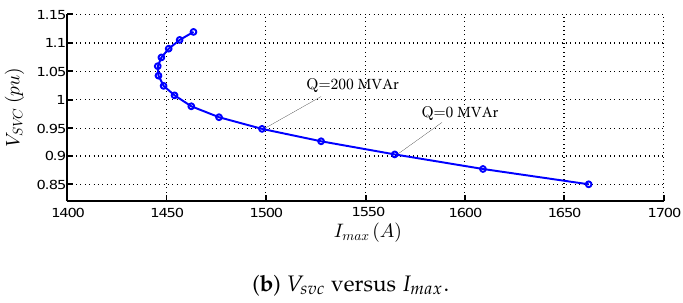
Figure 10. Steady-state relation among V svc , I max , and Q svc .